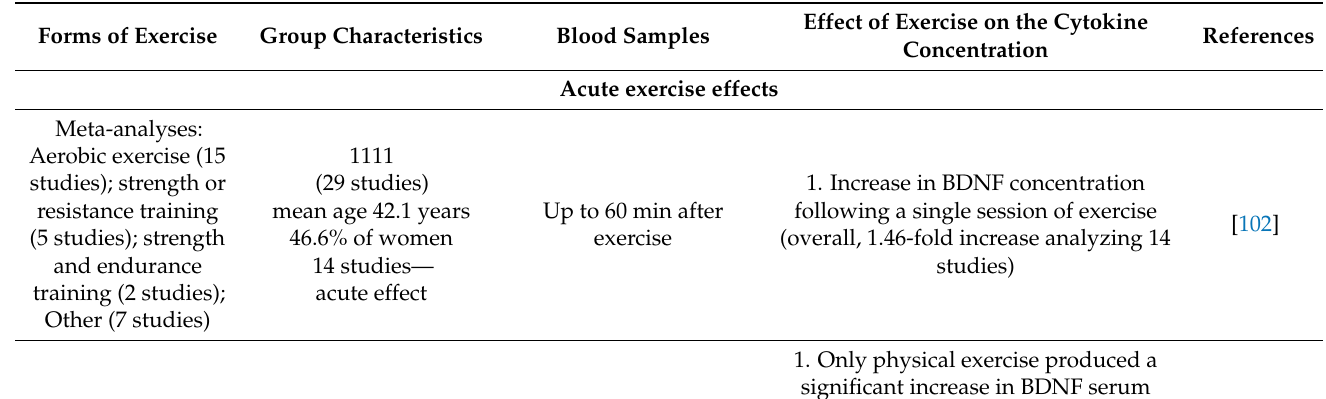
Table 5. Effects of exercise on